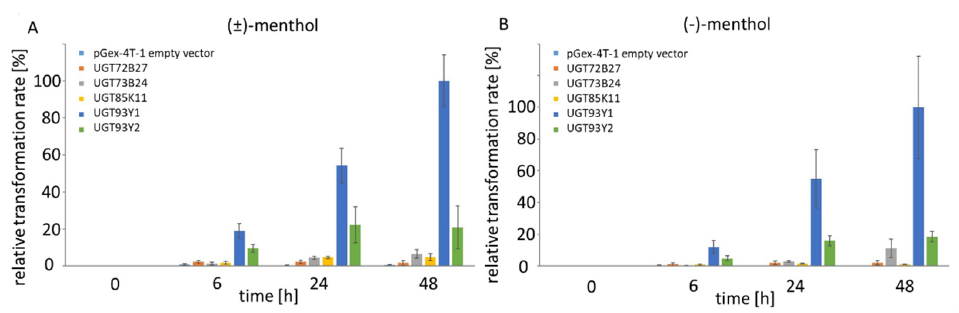
Figure 1. Relative biotransformation rate of UGT72B27, UGT73B24, UGT85K11, UGT93Y1 and UGT93Y2 in % towards (±) ‐ menthol ( A ) and ( ‐ ) ‐ menthol ( B ). The intensity of the pseudo ‐ molecular ion m/z 363 [M+HCOO] ‐ of menthyl glucoside was determined, and the UGT with the highest value was set to 100%. Samples were analyzed after 6, 24 and 48 h after substrate addition. pGEX ‐ 4T ‐ 1 served as negative control.